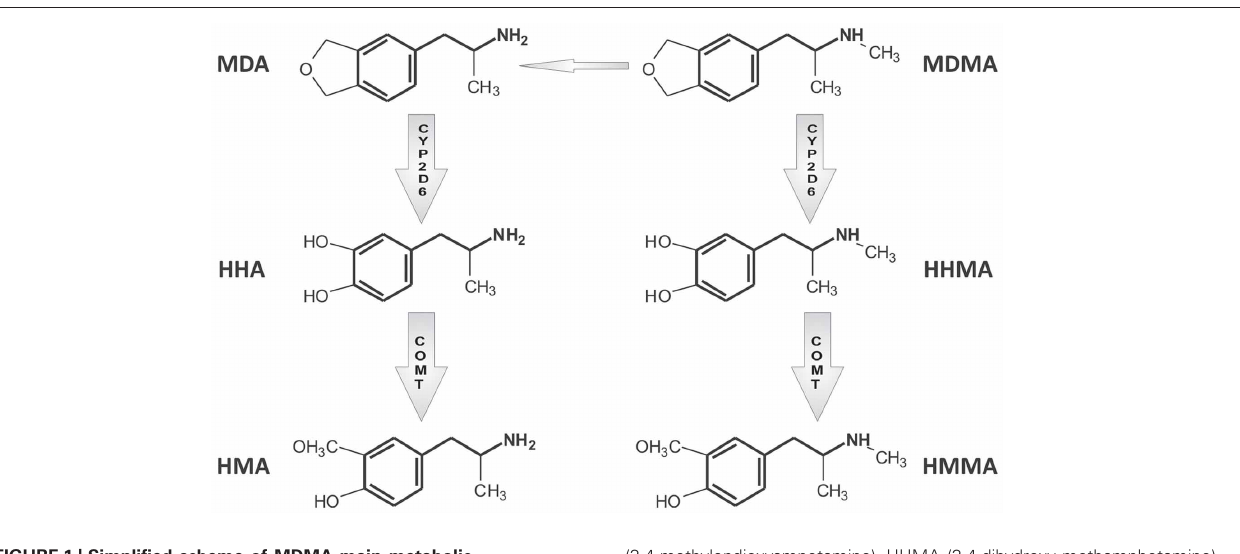
(3,4-methylendioxyampetamine), HHMA (3,4-dihydroxy methamphetamine), HMMA (3-methoxy-4-hydroxymethamphetamine), HHA (3,4-dihydroxyamphetamine), and HMA